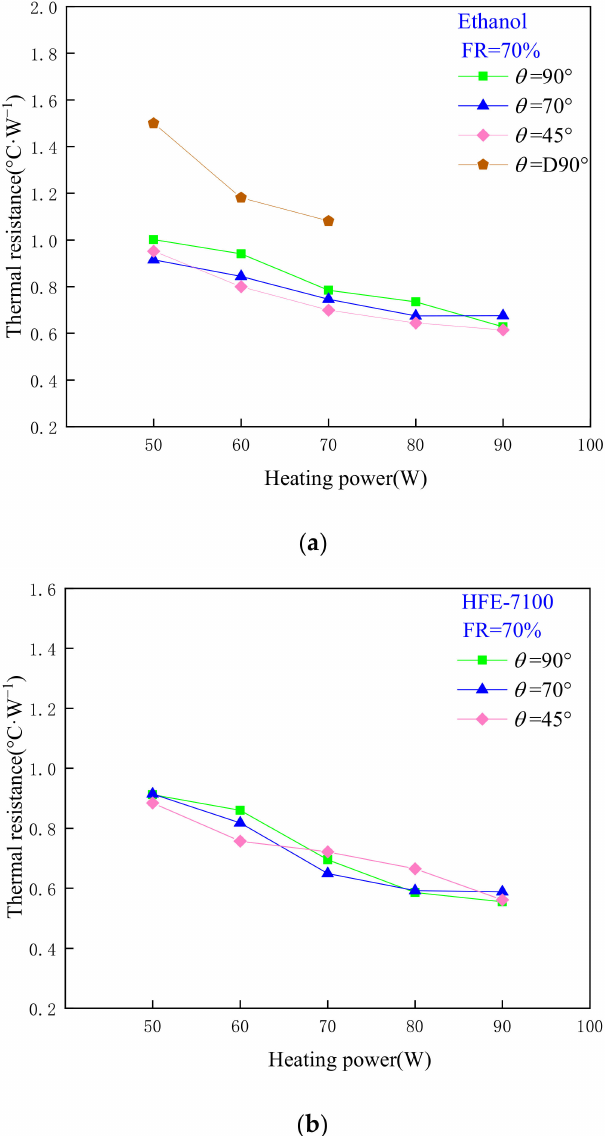
Figure 5. Variation of thermal resistance of pulsating heat pipe with installation angle under non- uniform heat flux: ( a ) Ethanol ( b )